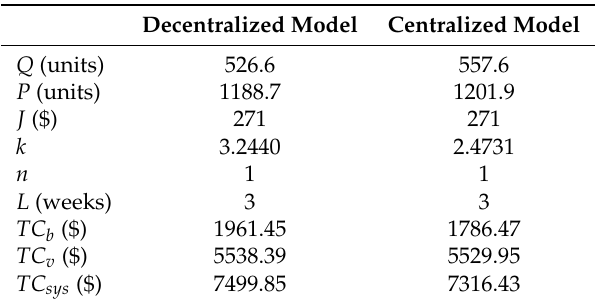
Table 4. Optimal solution for numerical